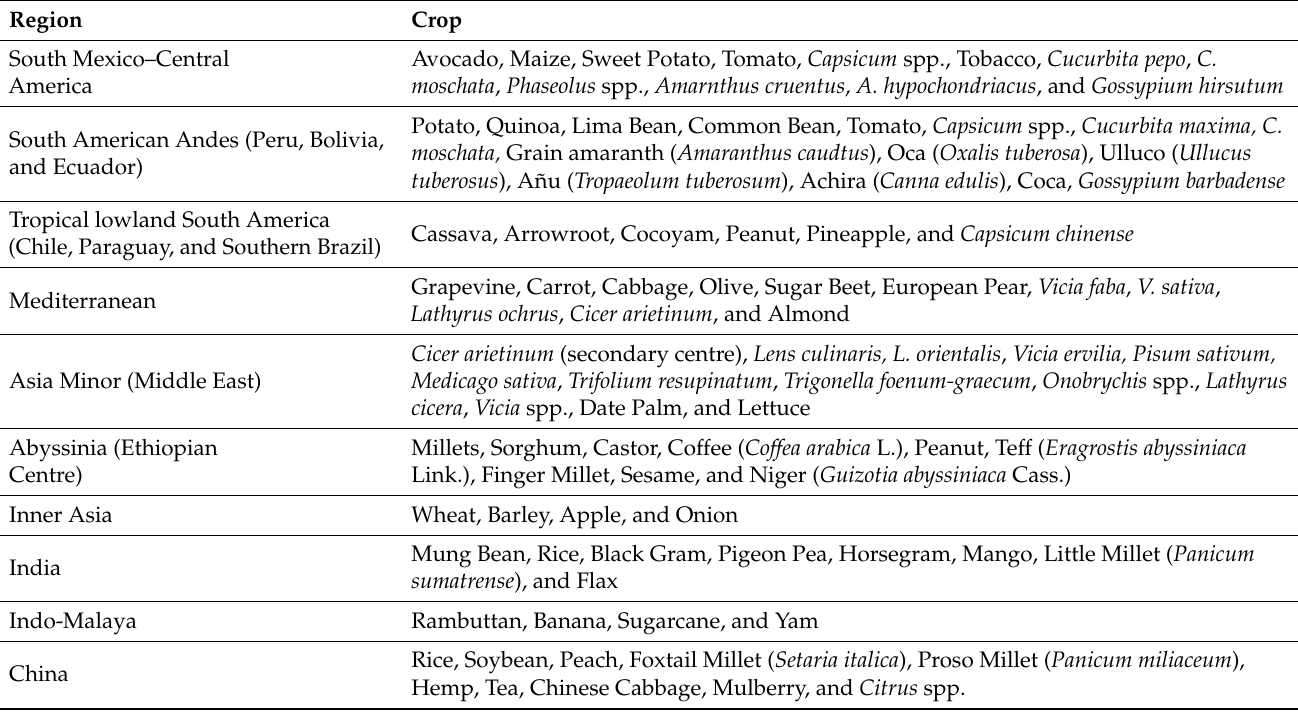
Table 2. Some of the crop species domesticated in different centres of diversity according to Zhukovsky